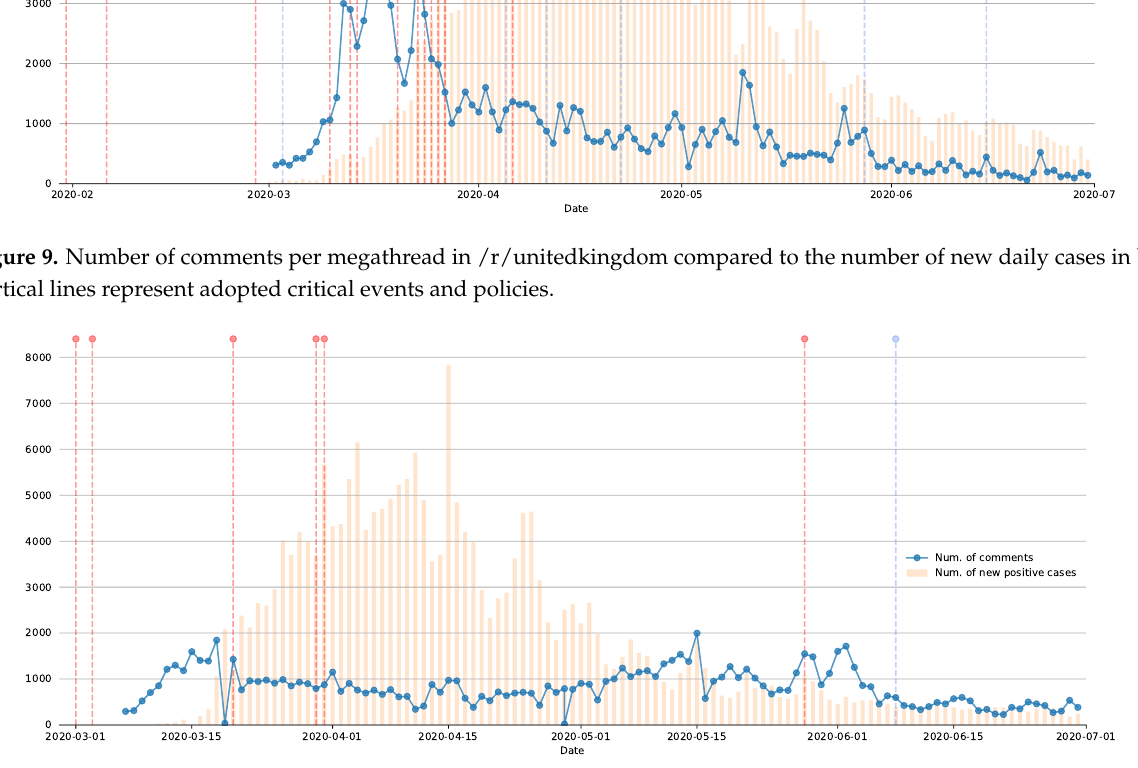
Figure 10. Number of comments per megathread in /r/nyc compared to the number of new daily cases in New York City. Vertical lines represent adopted critical events and